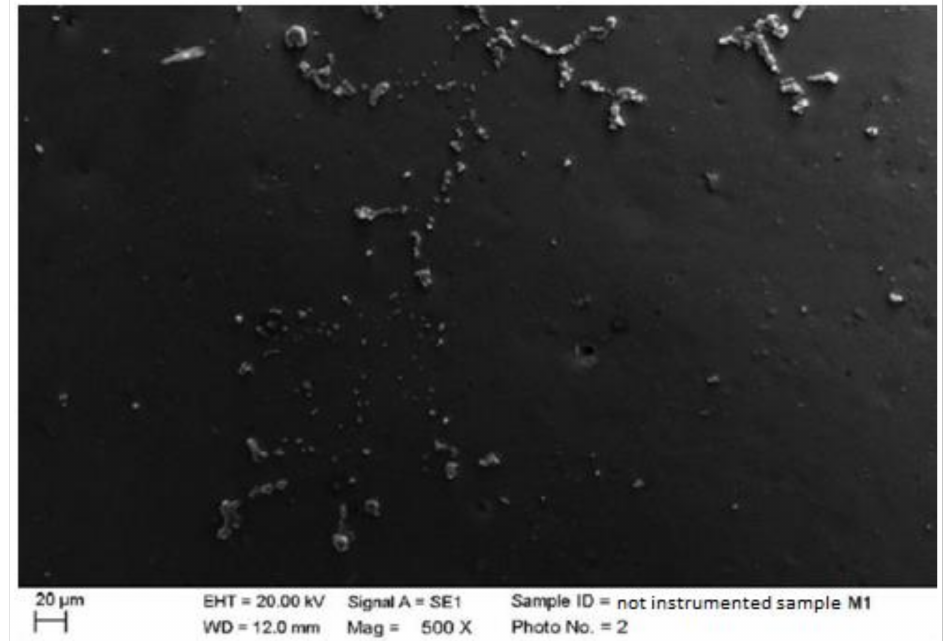
Figure 4. Non-instrumented ceramic sample M1 (500 ×